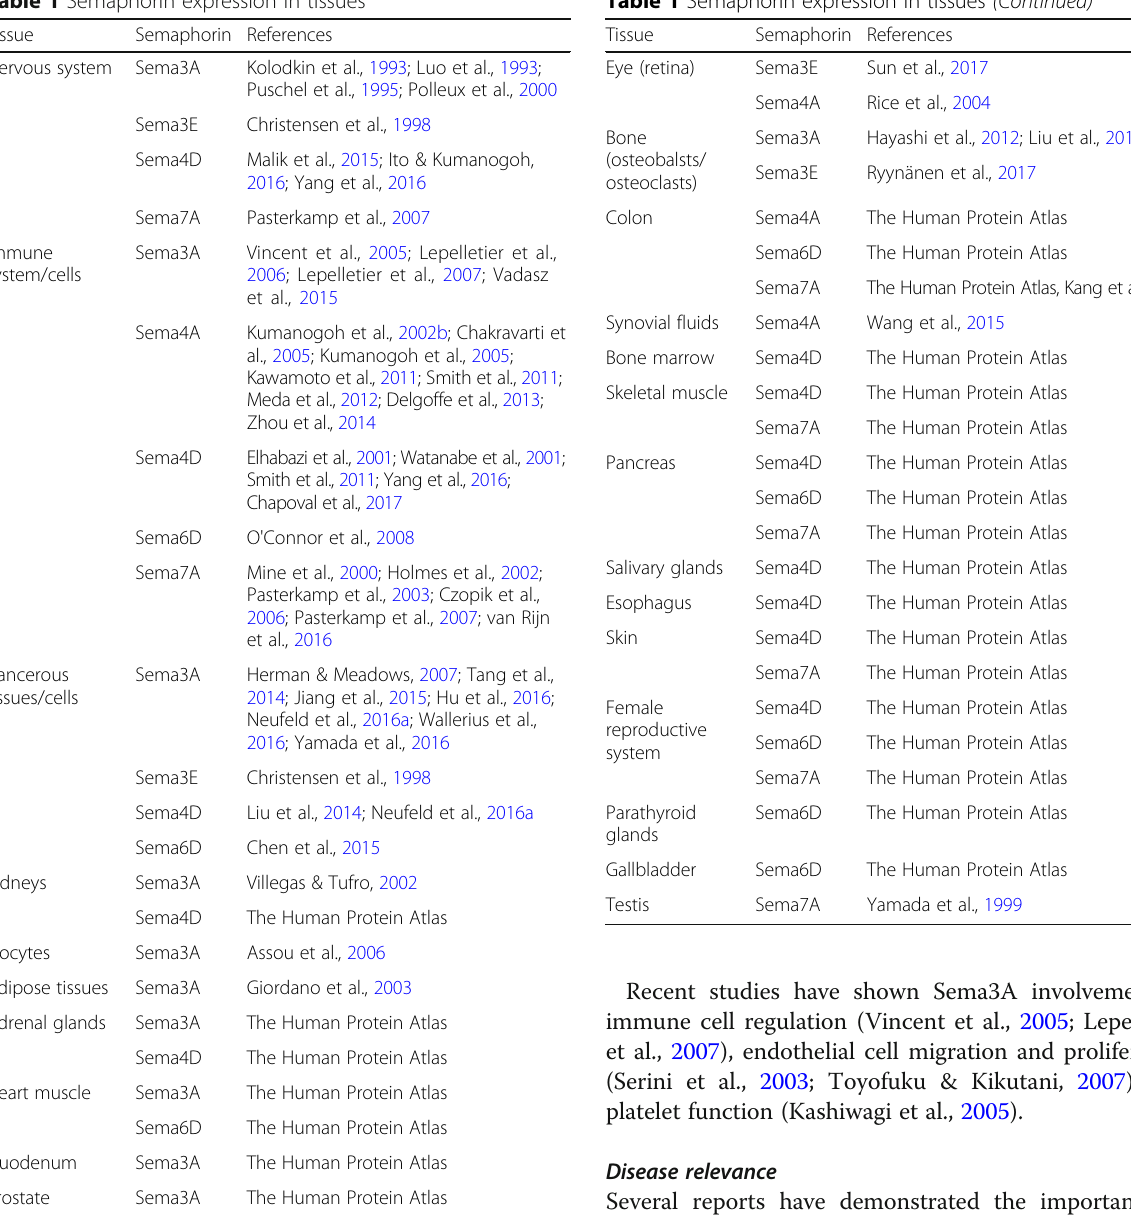
Table 1 Semaphorin expression in tissues